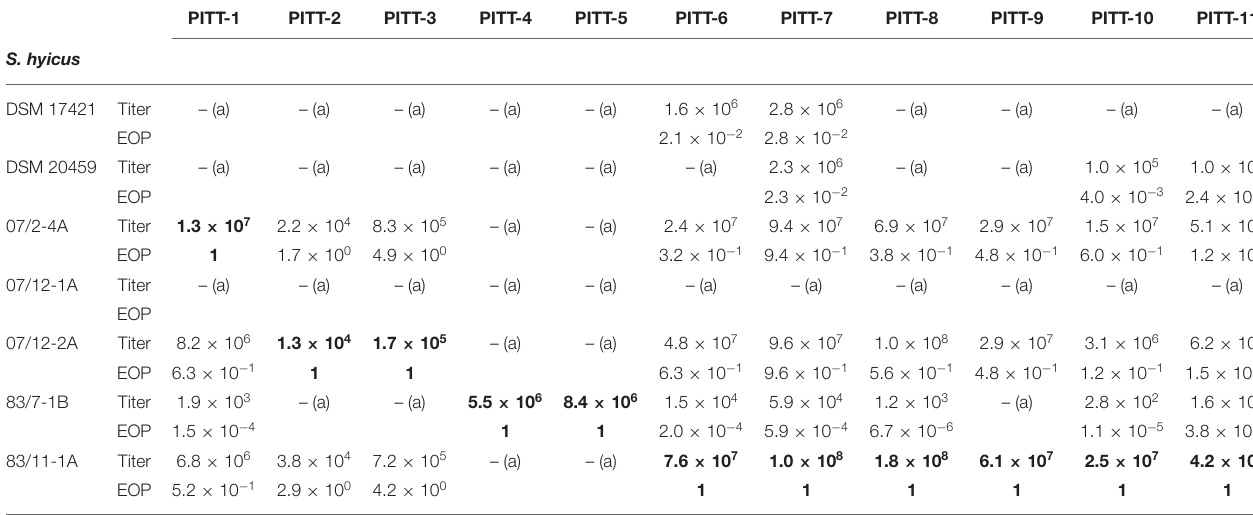
TABLE 2 | Phage titers (plaque-forming units, pfu/ml) and efficiency of plating